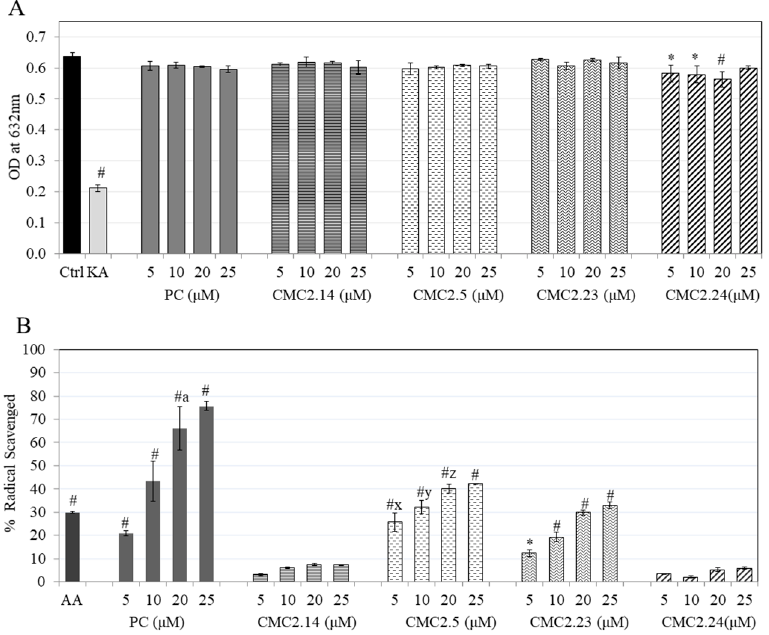
Figure 4. ( A ) Copper chelating activity indicated by reduction in absorbance at 632 nm was tested for compounds; * p < 0.01 and #- p < 0.001 vs. Ctrl; One-way ANOVA followed by Tukey’s test; ( B ) DPPH radical antioxidant activity indicated by % radical scavenged for compounds; * p < 0.01 and # p < 0.001 vs. control (baseline considered as 0% scavenged); Letter a— p < 0.001 vs. positive control AA (20 µM); Letter x— p < 0.001 vs. CMC2.23 at 5 µM; Letter y— p < 0.01 vs. CMC2.23 at 10 µM; Letter z— p < 0.05 vs. CMC2.23 at 20 µM; Data are mean ± SD (n = 3 per group); One-way ANOVA followed by Tukey’s test.